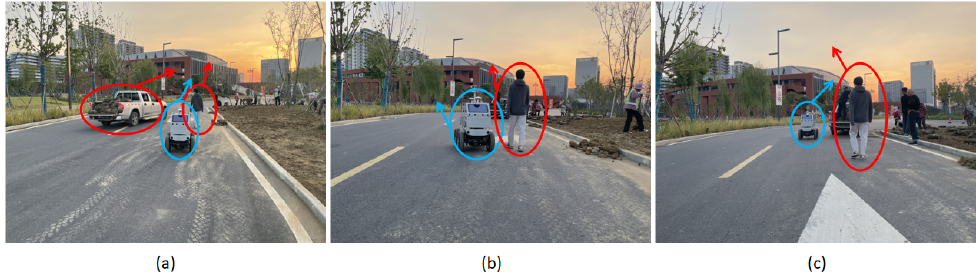
Figure 22. Dynamic obstacle avoidance in the park scene: ( a ) when the robot is far away from pedestrians; ( b ) the robot avoids pedestrians; ( c ) the robot continues to perform navigation